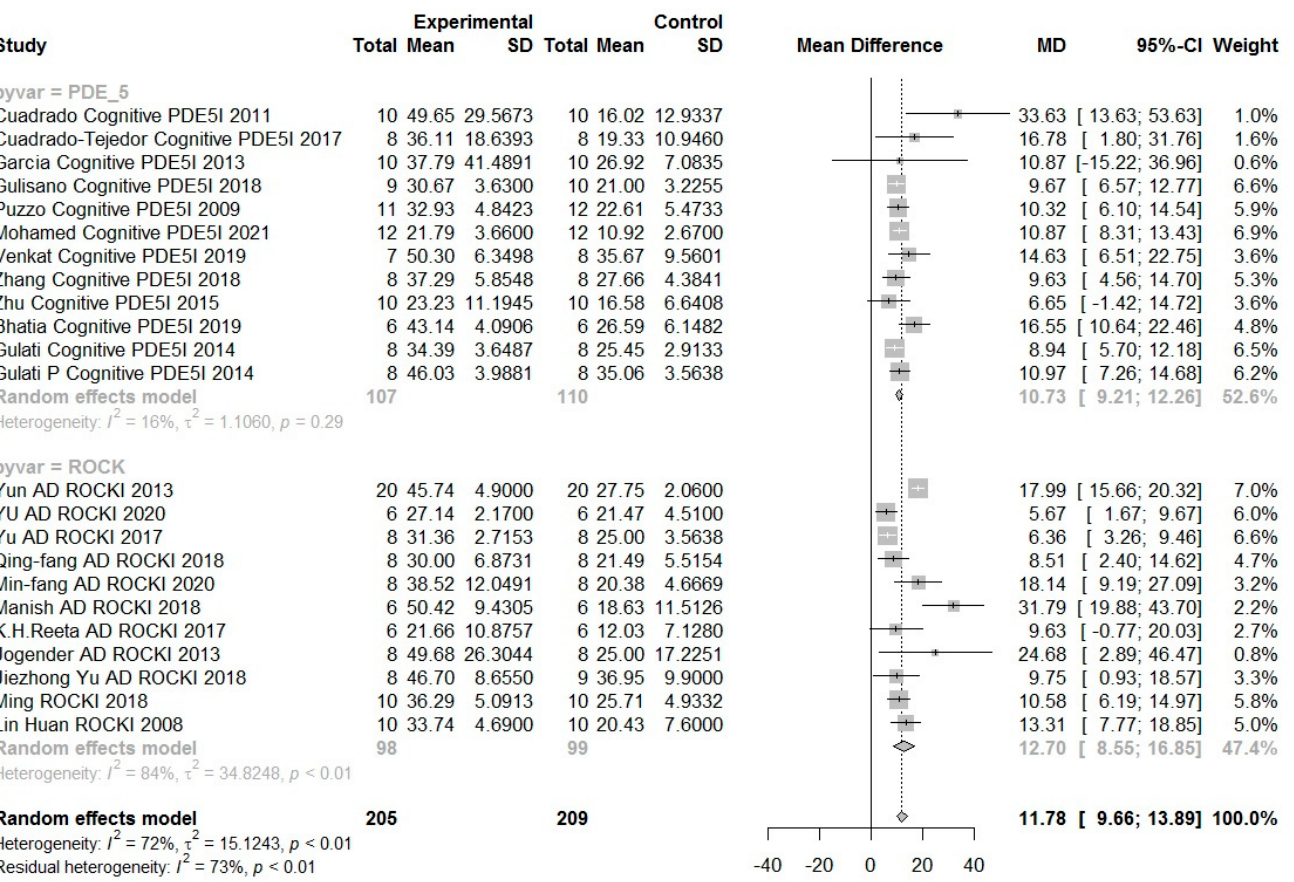
Figure 6. In the forest plot, the difference between the control group and the experimental group of each subgroup was analyzed by mean difference (MD). Each subgroup is located at the top and bottom with PDE-5 inhibitors and ROCK inhibitors. Because of the high heterogeneity, each group was analyzed by dividing it into subgroups.